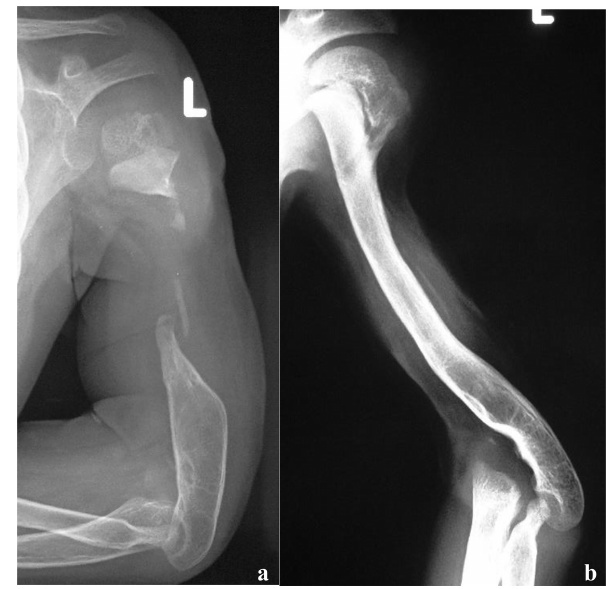
Figure 5. (a) Radiographs, at presentation, of a 2-year-old boy who presented with bone loss and sequelae of septic arthritis of the elbow joint. There was a history of two previous attempts to fill the gap with cortico-cancellous grafts. Reconstruction options were limited by the short stumps, severe osteopenia and the previous clinical his- tory. (b) Radiographs taken at last follow-up, 4 years after VFF; soundly integrated graft with excellent functional